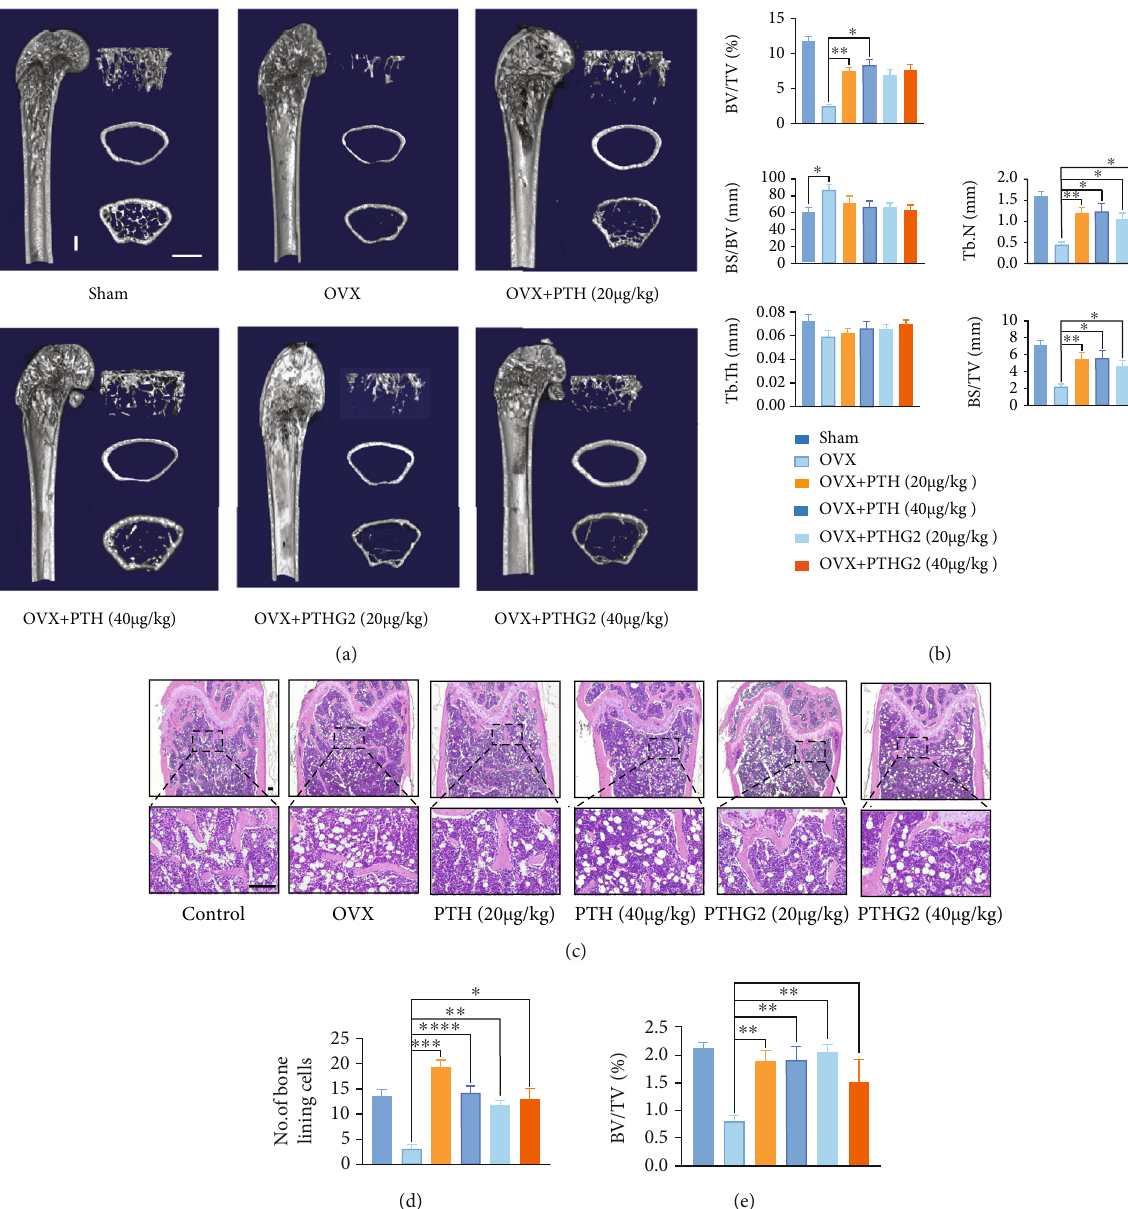
Figure 2: Intermittent injection of PTHG2 alleviated bone loss in mice induced by OVX. (a) Representative micro-CT images of femora of control group and curative groups; scale bar, 1 mm; (b) quantitative micro-CT of bone volume per tissue volume (BV/TV), number of trabeculae (Tb. N), relative bone volume fraction (BS/TV), bone surface area/bone volume (BS/BV), trabecular thickness (Tb. Th), and bone surface area/tissue volume (BS/TV); (c) H&E staining of femora. Scale bar, 100 μ m; (d) quantitative number of lining cells. (e) Quantitative H&E staining of bone volume per tissue volume (BS/TV). Scale bar, 30 μ m, n = 6 per group ( ∗ p < 0 : 05 , ∗∗ p < 0 : 01 , ∗∗∗ p < 0 : 001 , ∗∗∗∗ p < 0 : 001